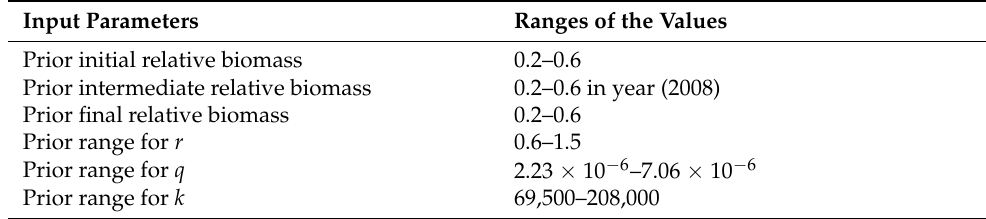
Table 1. Distributions of biomass (B), k, q, r range as prior for the CMSY used in this study.